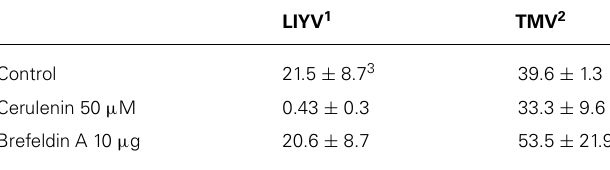
Table 1 | Effects of cerulenin and brefeldinA on LIYV andTMV infectivity in N. benthamiana protoplasts.